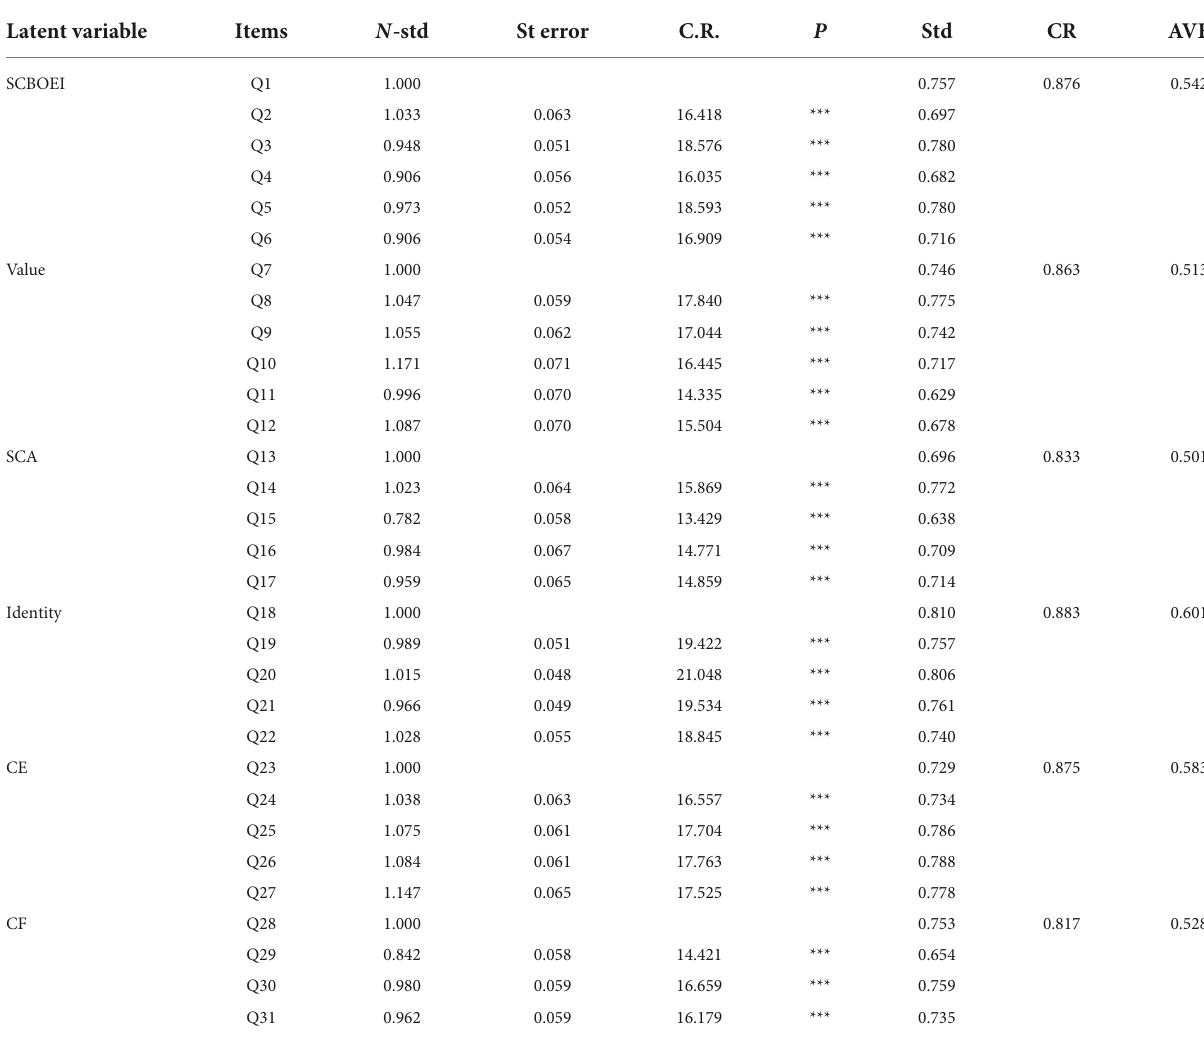
TABLE 7 Aggregation validity